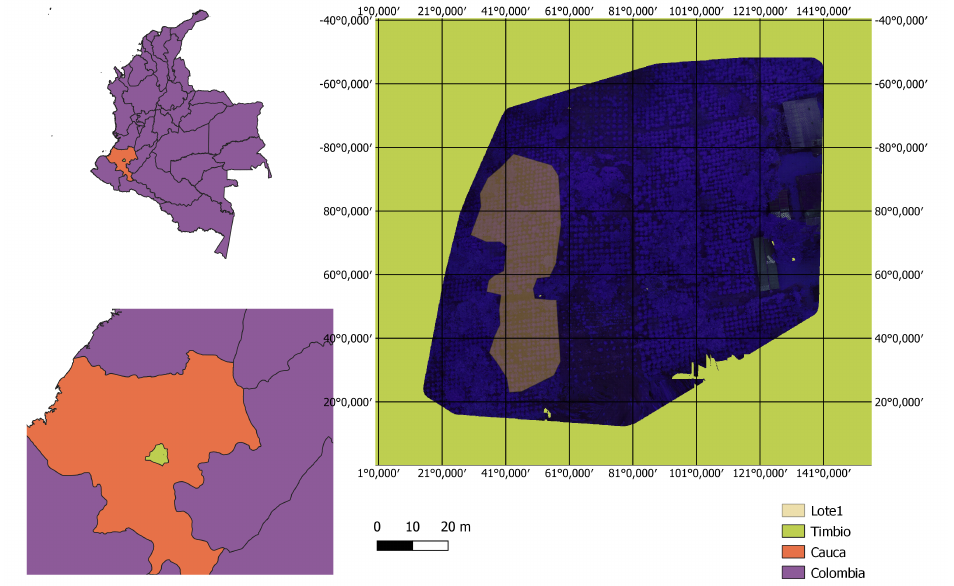
Figure 1. The map on the left shows the distribution by departments of Colombia, in which Cauca is located. On the left is the geolocated orthophoto of “La Sultana” farm. On the other hand, the image taking was carried out during the flowering stage from July to August 2021. Manual yield samples were taken from three coffee plantations of the Castillo variety between November and December